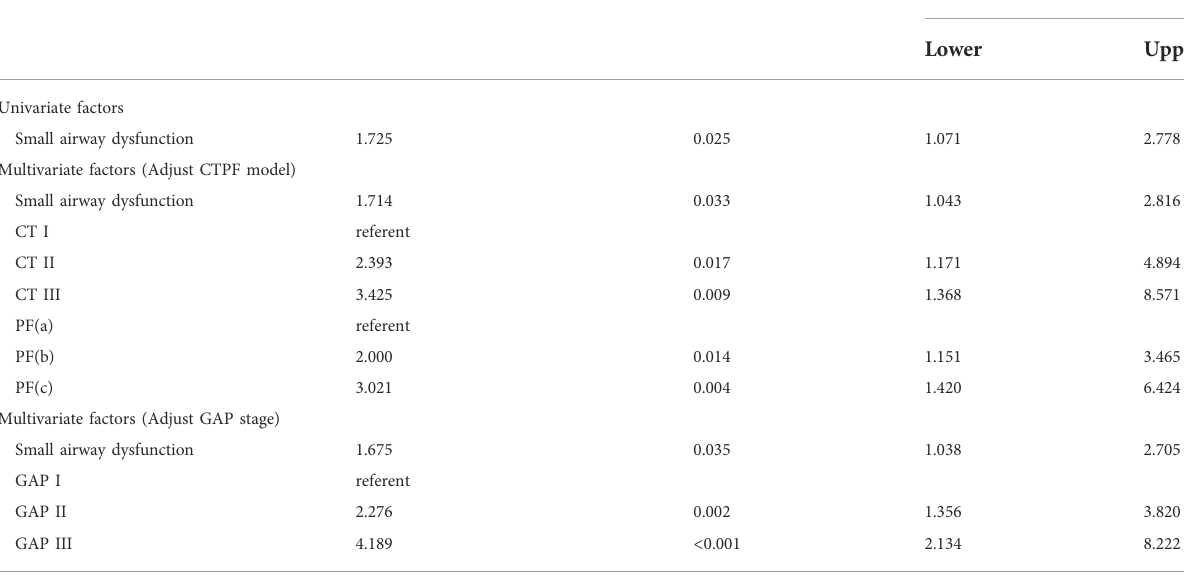
TABLE 5 Fine-gray death risk regression analysis results from different model